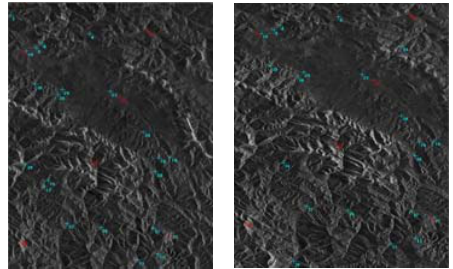
Figure 3. the same side-looking direction stereo images The base-height ratio between two images is 0.078, the forward intersection angle between the homologous and corresponding ground points is about 12 degree, and the two image overlap area greater than 80%, in this area totally have 22 known coordinates ground points, the relationship between image and the ground point distribution shown in Figure (4). TerraSAR-X opposite side-looking direction stereo images got in July 2009, the geographical coordinate of image center area is （ 31.15, 94.32 ） . the sample resolution in azimuth direction and in slant range direction for the two SAR images respectively are (2.03m, 1.36m), (1.58m, 1.36m). The elevation of surveying area is at 3800m -5600m, the base-height ratio is 1.27, and the forward intersection angle of ground point is 67 degree, images overlap area within the known geographical coordinates points are total of 12, the relationship between the two scene images and ground points distribution shown in Figure (5) below.